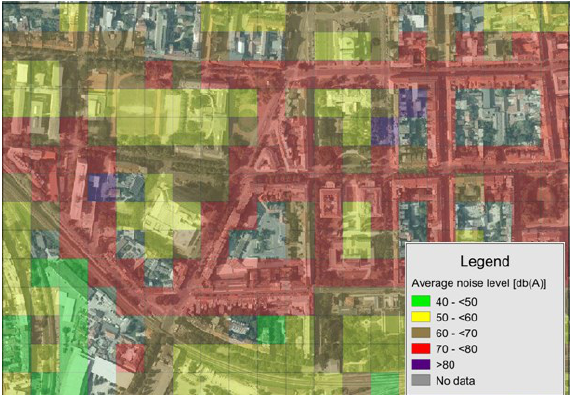
Figure 9. Representation of calculated average noise level displayed in QGIS on digital ortophoto (Vuković,